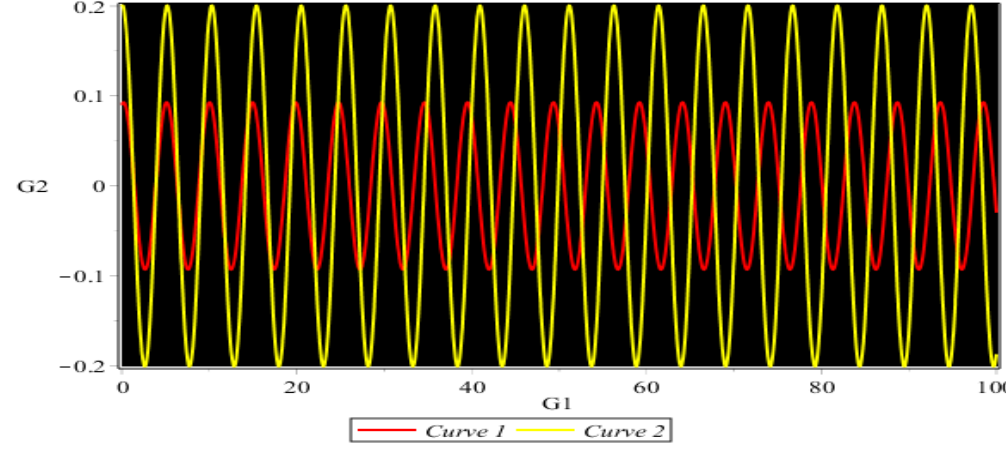
Figure 6. Sensitivity presentation for curve 1 at (0.09, 0.03) and curve 2 at (0.2, 0.02).